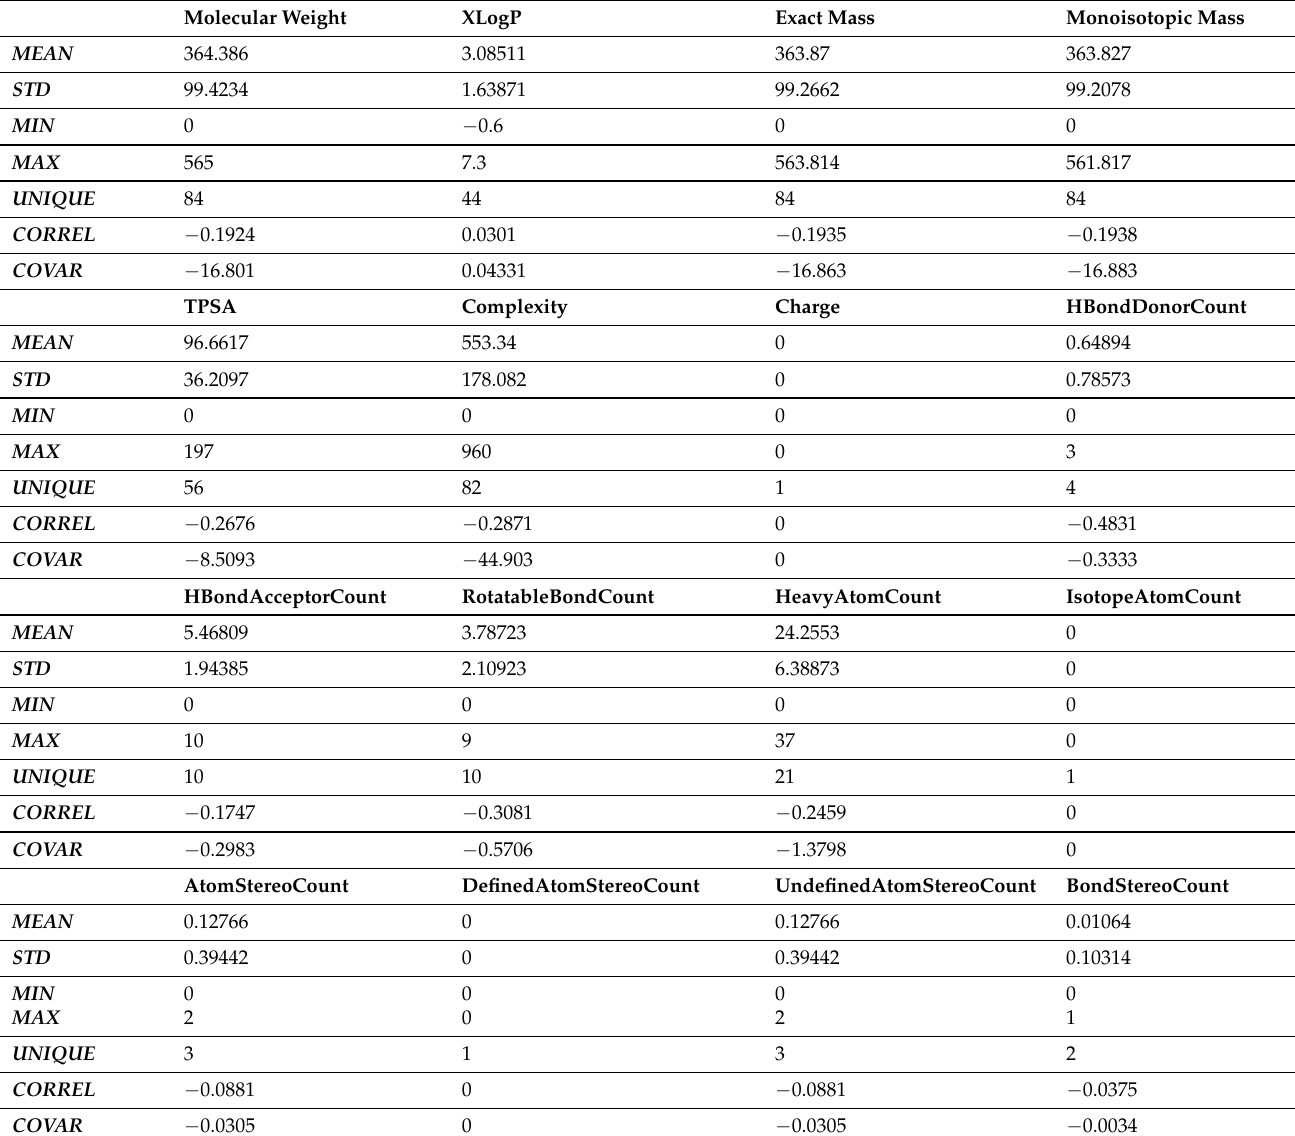
Table A1. Descriptive statistics of the individual numerical values in the